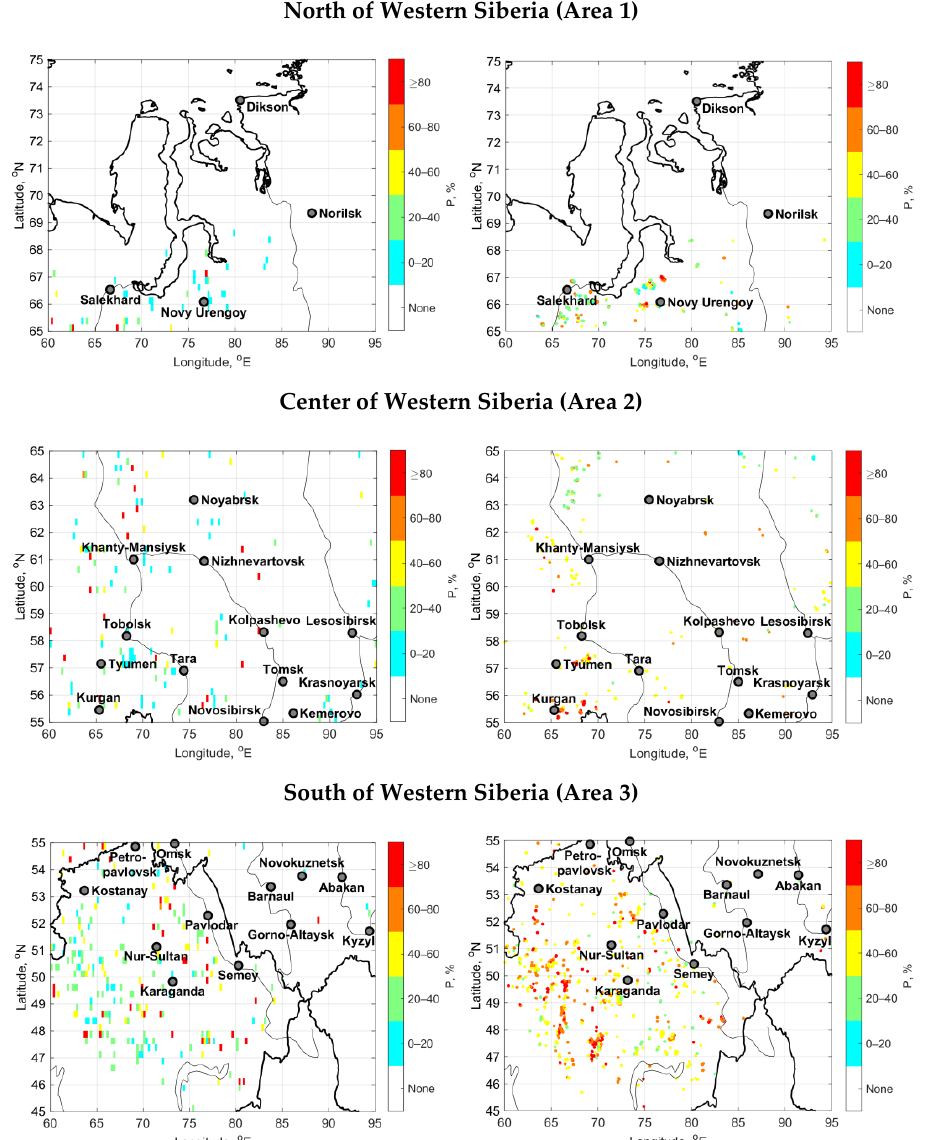
Figure 7. Spatial distribution of the probability values between the number of lightning and hotspots in Western Siberia during the warm season of 2016–2021: left panel—cases in each cell with smolder period 1 day ( P ), right panel—cases applying D max = 10 km and ∆ t max = 10 days ( B ). Table 1. Relation (in %) of total number of hotspots that are likely caused by lightning discharge ( B > 0) to total number of hotspots in Western Siberia over the period of 2016–2021.